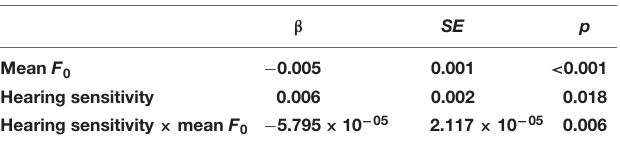
TABLE 6 | Fixed effect estimates for the best-fitting models of performance for the analysis of the valence data for the older adults only; bold indicates significant results, number of observations = 612, AIC = 767.8.